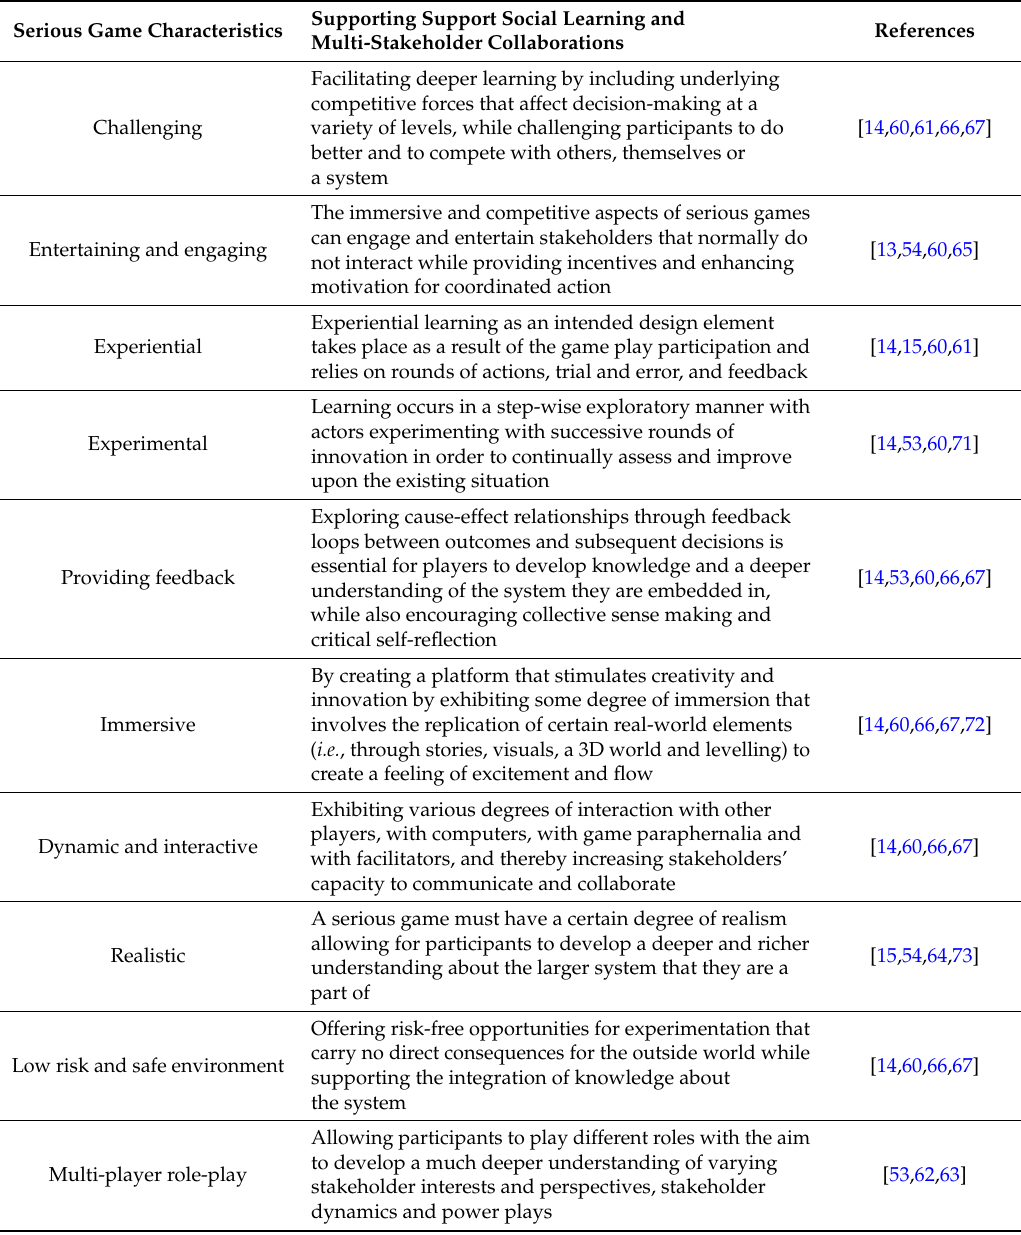
Table 2. Characteristics of serious games in support of social